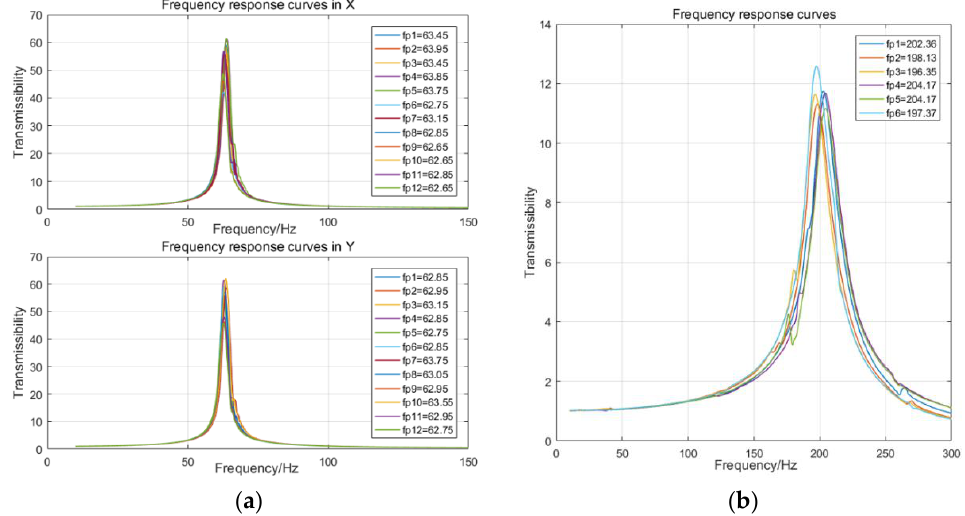
Figure 7. Frequency response curves obtained from flexible components tests: ( a ) Frequency response curves of flexible joints; ( b ) Frequency response curves of legs.